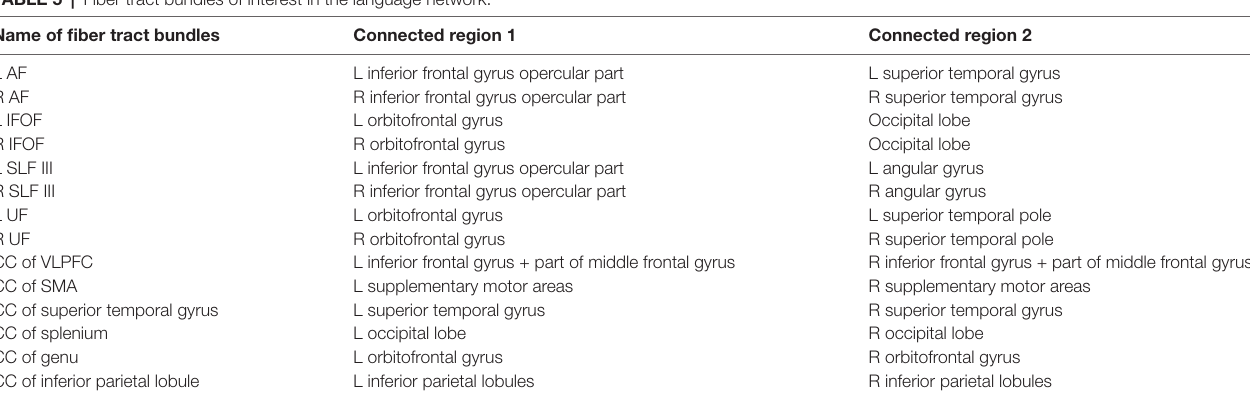
TABLE 5 | Fiber tract bundles of interest in the language